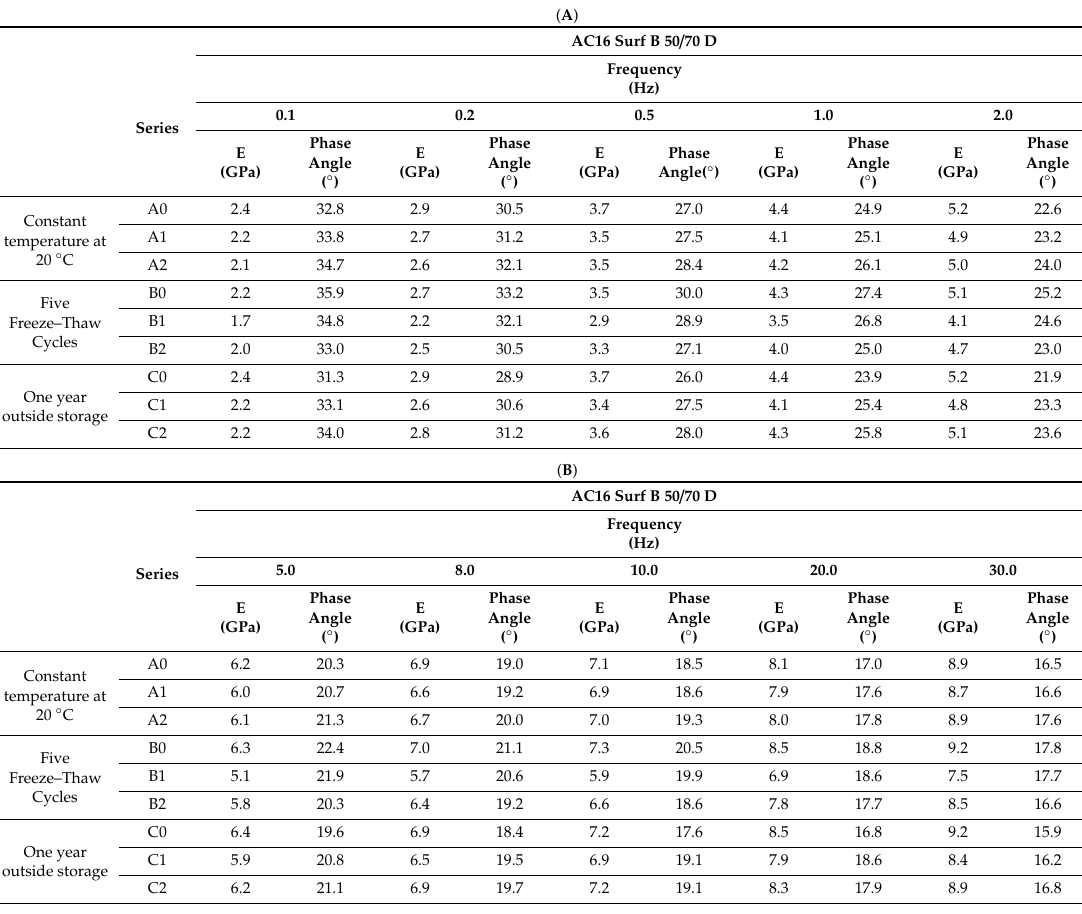
Table 9. Dynamic modulus